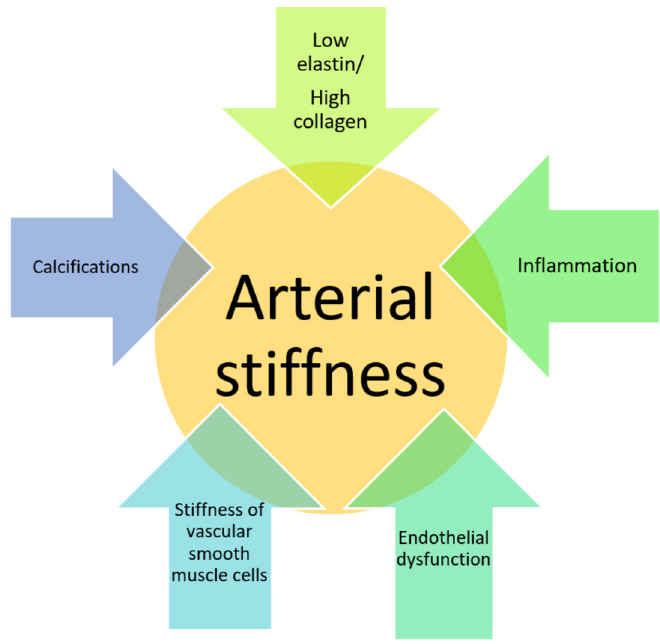
Figure 1. Factors that contribute to arterial wall